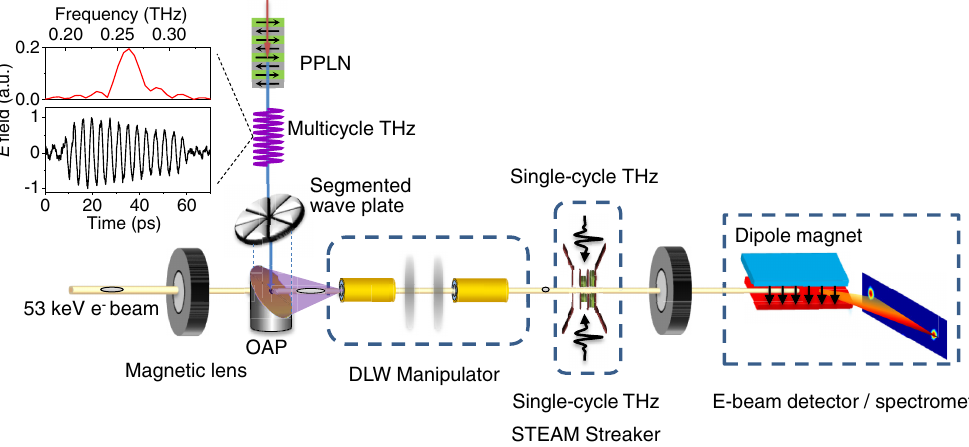
FIG. 1. Experimental setup. A small fraction of the 1030-nm infrared optical beam is converted to 257-nm based on two-stage second harmonic generation. The 257-nm UV pulse is directed onto a gold photocathode generating electron pulses, which are accelerated to 53 keV by the dc electric field with around 1 fC charge. The same infrared laser also drives a multicycle THz generation stage and two single-cycle THz stages for the DLW manipulator and the STEAM streaker,